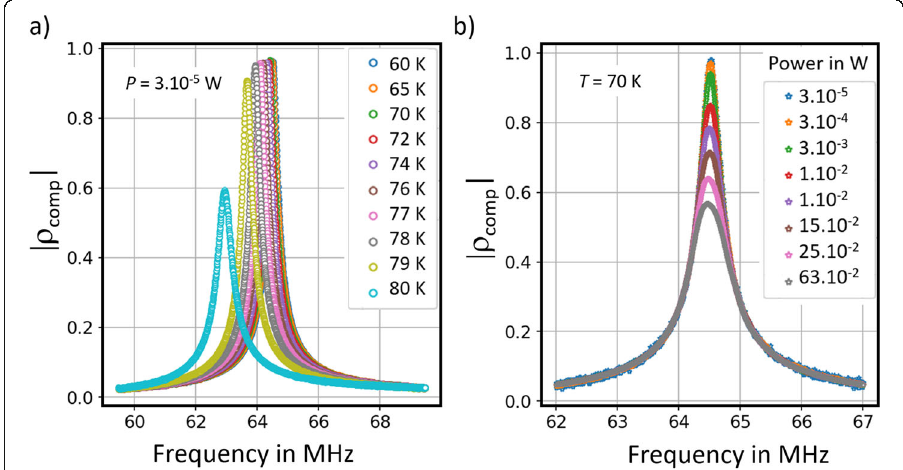
Fig. 4 The RF response of the HTS coil as a function of frequency ( a ) for different temperatures varying from 60K to 83K at 3×10 − 5 W, and ( b ) for different incident power values (from 3 × 10 − 5 W to 63×10 − 2 W) at